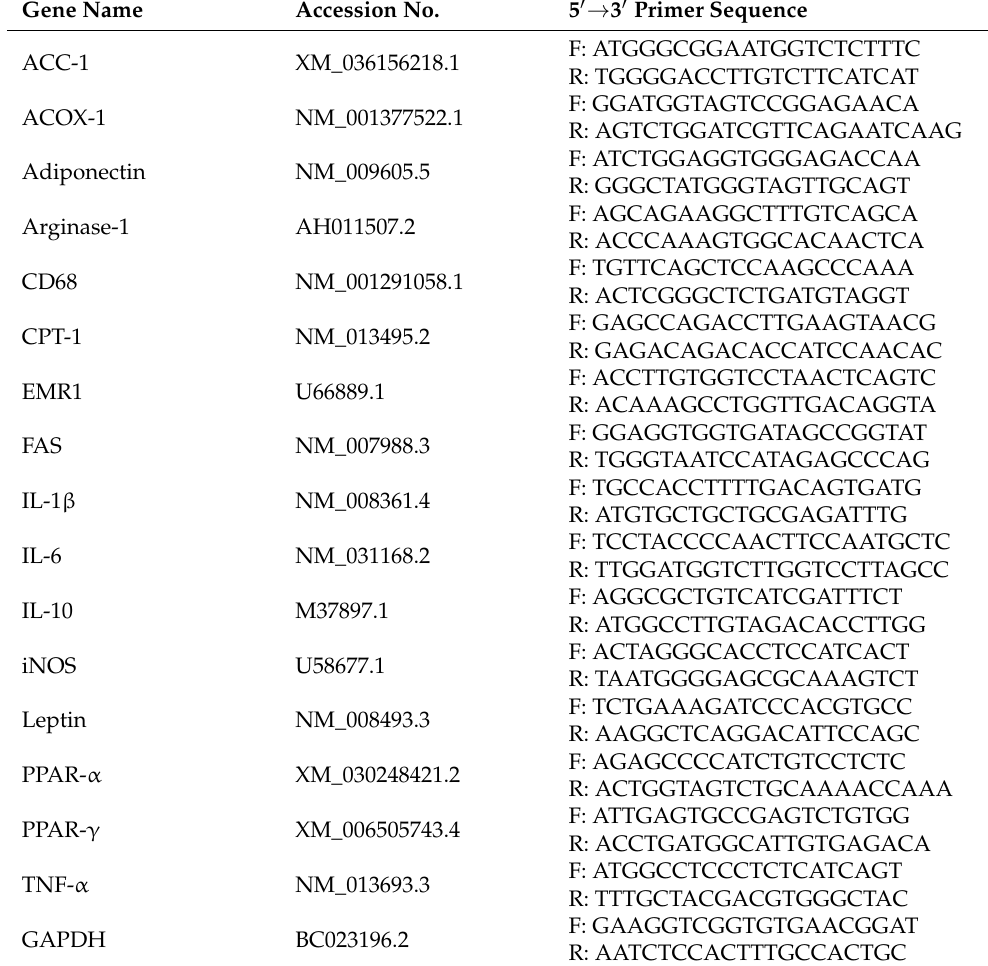
Table 5. Sequences of oligonucleotide primers used in the PCR